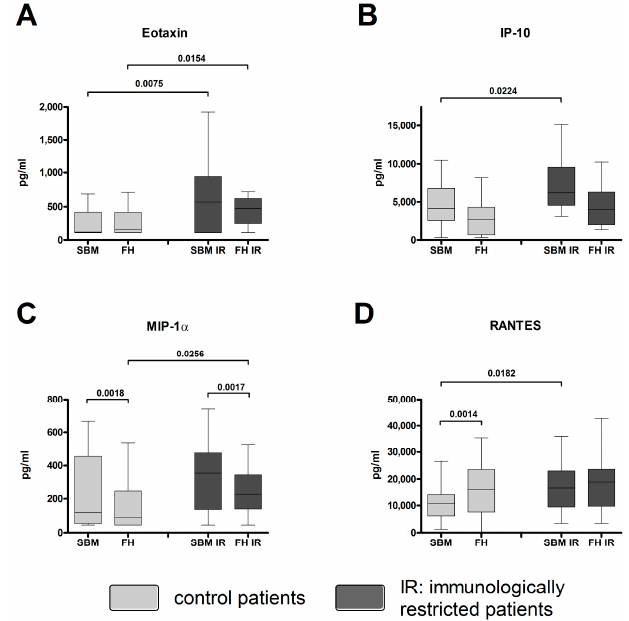
Figure 4. Chemokines are up-regulated in FH/SBM of immunologically restricted patients. Supernatants from FH and SBM of immunologically restricted patients (FH IR/SBM IR: dark grey) and controls (FH/SBM: light grey) were analyzed for the concentrations of chemokines via multiplex suspension array. ( A ) Eotaxin/CCL11; ( B ) Interferon gamma-induced protein 10 ( IP-10/CXCL10); ( C ) Macrophage inflammatory protein 1 α ( MIP-1 α /CCL3); ( D ) Regulated on activation, ( C ) Macrophage inflammatory protein 1 α (MIP-1 α /CCL3); ( D ) Regulated on activation, normal T normal T cell expressed and secreted ( RANTES/CCL5). Controls n = 42, IR patients n = 20. IR- patients vs. controls Mann-Whitney U test, FH vs. corresponding SBM Wilcoxon test, p -values < 0.05